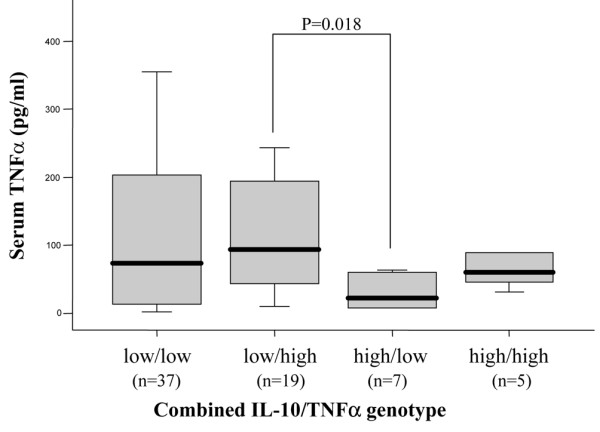
Combined IL-10/tumor necrosis factor (TNF)α genotype influences TNFα serum levels in SLE patients without antimalarial treatment. After determination of the allele present at positions -1,082 and -308 of the IL-10 and TNFα gene promoters, respectively, patients were classified as genetically high (GG) or low (AA/AG) IL-10 producers and high (AA/AG) or low (GG) TNFα producers. Box plots represent TNFα serum levels in SLE patients not receiving antimalarial therapy classified according to the four possible IL-10/TNFα combined genotypes. Differences were evaluated by the Mann-Whitney U test.